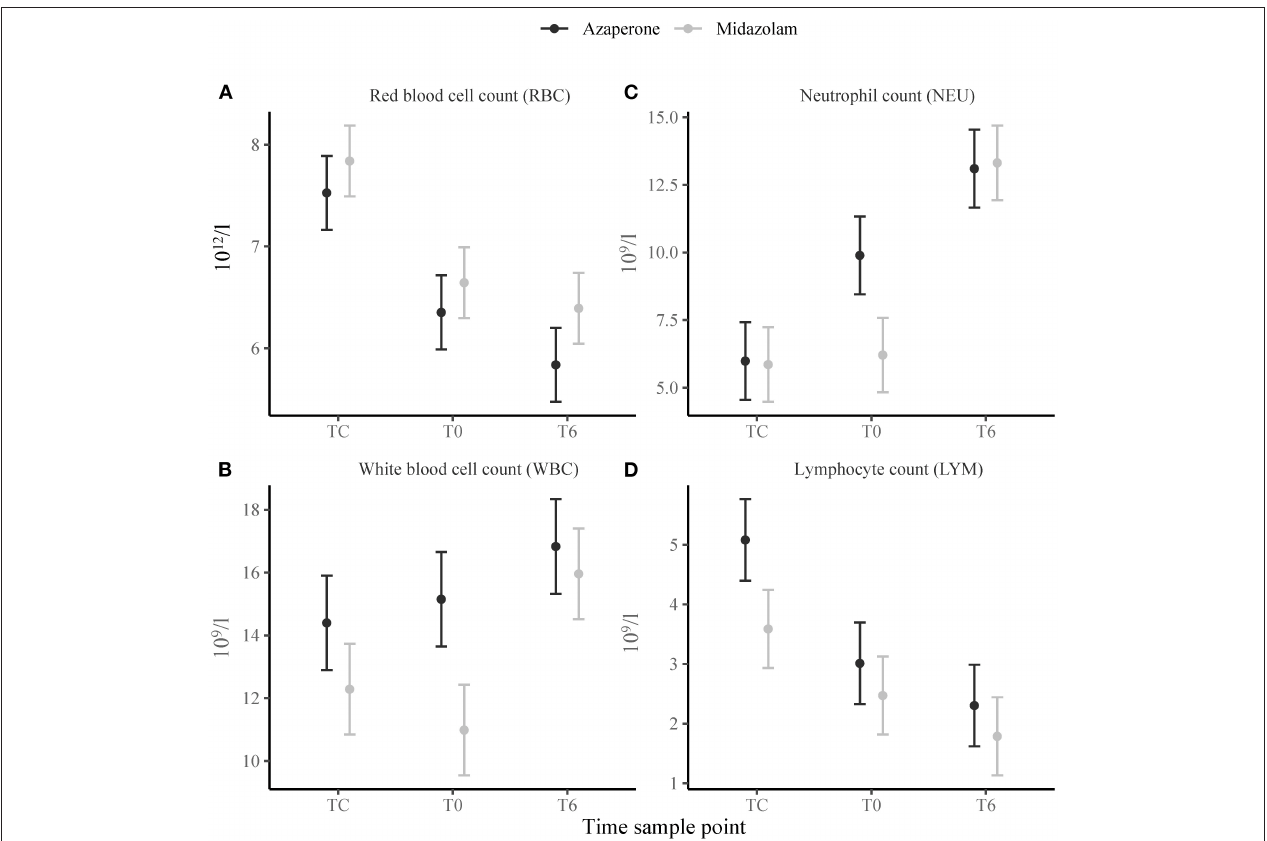
FIGURE 1 | Means ± standard error of selected hematological variables: (A) Red blood cell count (RBC), (B) white blood cell count (WBC), (C) neutrophil count (NEU), (D) lymphocyte count (LYM) in white rhinoceroses captured and transported with either azaperone or midazolam. Time sample points: capture (TC), start of transport (T0), and 6 (T6) h of